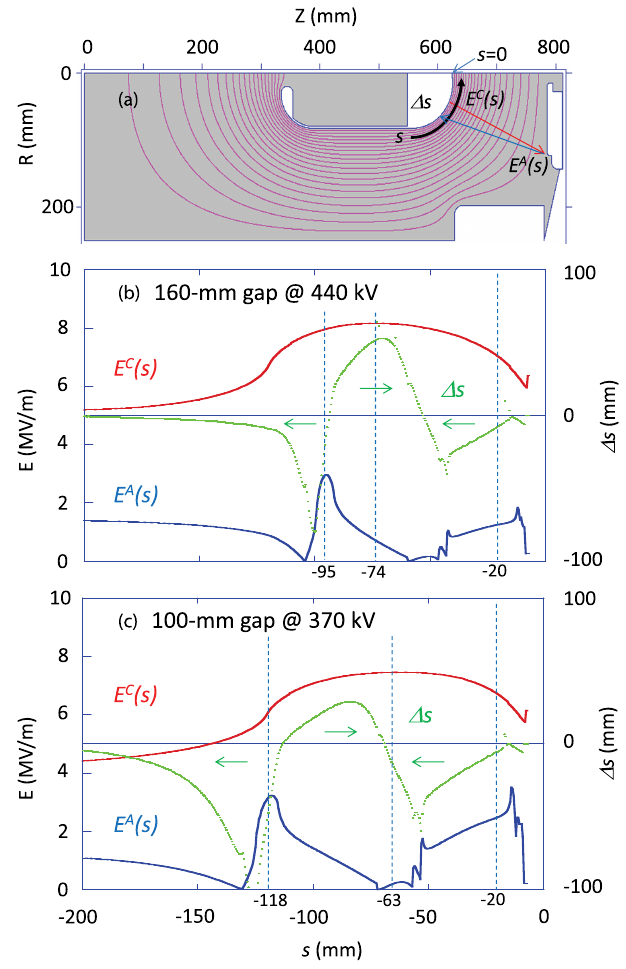
FIG. 14. (a) Radial cross section showing static electric field calculation for gun chamber with 160-mm gap and NEG pumps. Cathode surface electric field as a function of coordinate s along the surface of the cathode electrode is represented by E C ð s Þ , where s ¼ 0 mm corresponds to the photocathode center. Anode field at a position where electrons emitted from the cathode position s impinge is given by E A ð s Þ . The trajectory of the emitted electrons is represented by the red arrow. If a positive ion with zero energy is generated at the anode, it is accelerated by the field E A ð s Þ back to the cathode position of s þ Δ s . Here Δ s is the deviation from the original cathode position s . The trajectory of the positive ion is represented by the blue arrow. (b) Cathode field E C ð s Þ (red solid line) and corresponding E A ð s Þ (blue solid line) and Δ s (green solid circles) as a function of s at 440 kV for 160-mm gap. (c) Cathode field E C ð s Þ (red solid line) and corresponding E A ð s Þ (blue solid line) and Δ s (green solid circles) as a function of s at 370 kV for 100-mm gap. Figure 14(b) shows the absolute values of the surface electric fields E C ð s Þ (red solid line) and E A ð s Þ (blue solid line) for a 160-mm gap at V I ¼ 440 kV. The green solid circles show Δ s . Secondary electrons can be generated from the cathode position at a deviation of Δ s from its original position s . The directions of the deviations are